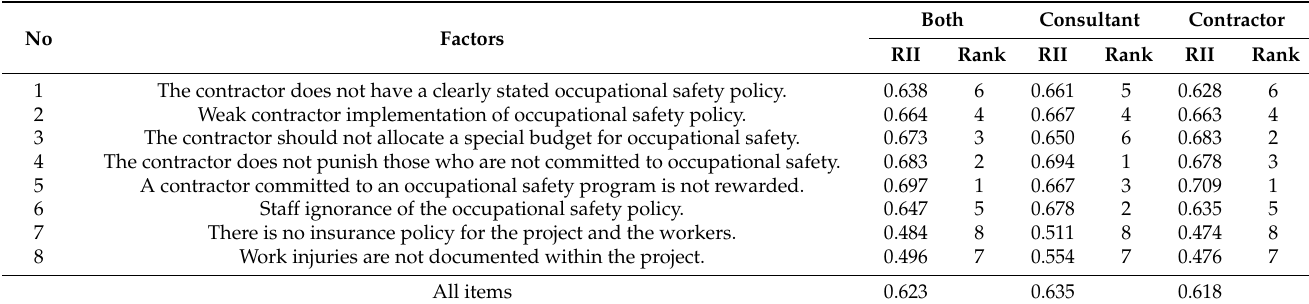
Table 5. Rank and Relative Importance Index (RII) of items related to safety policy barriers. No Factors